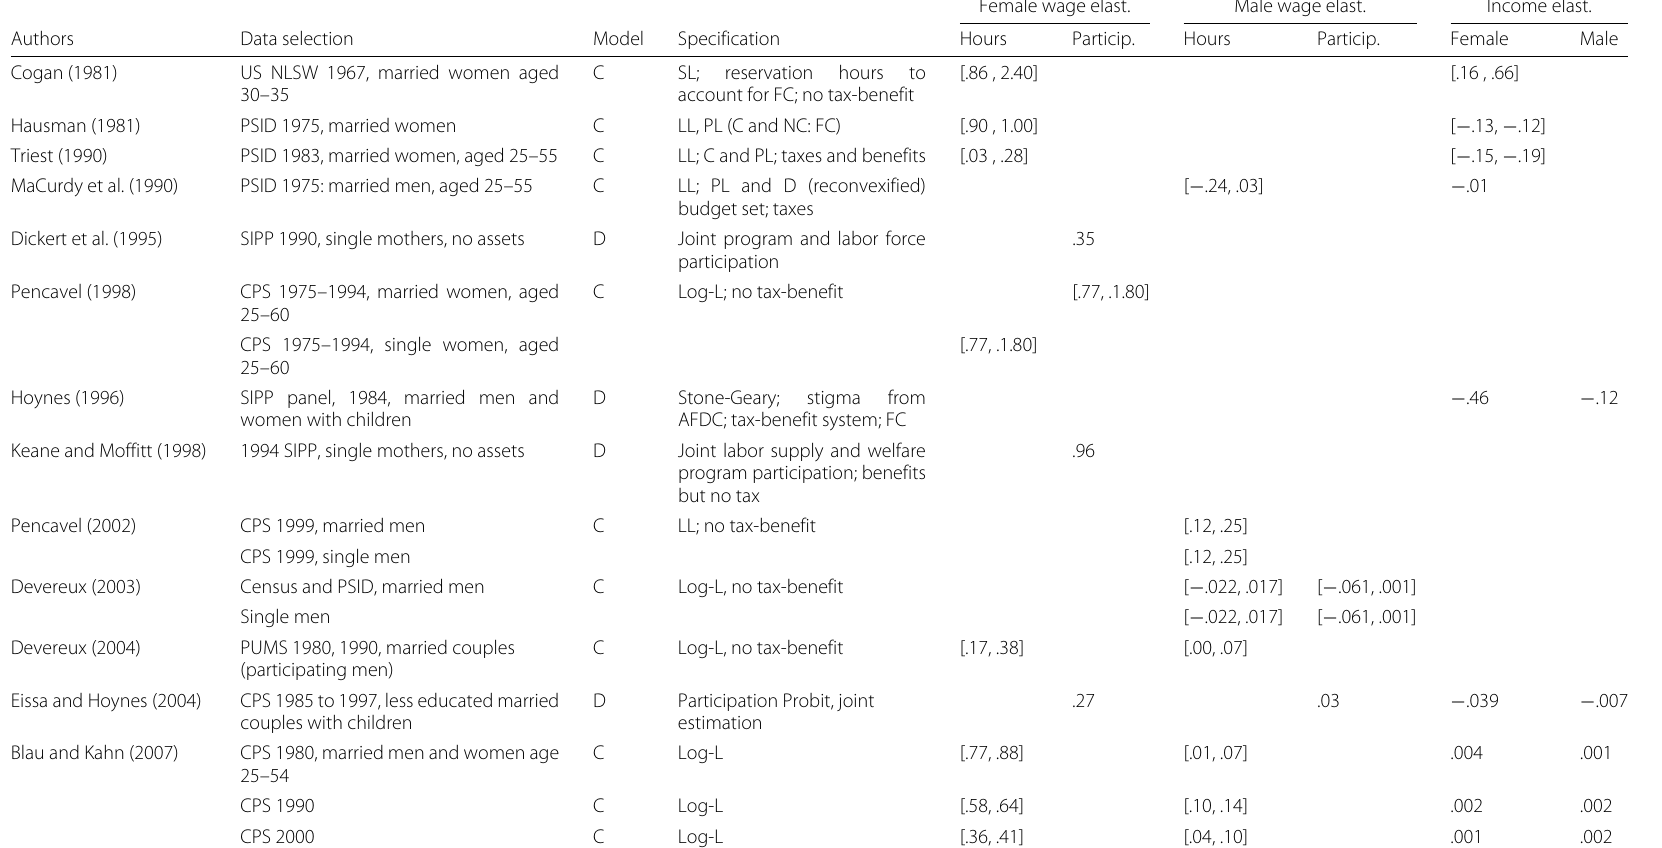
Table 3 Labor supply elasticities for the USA